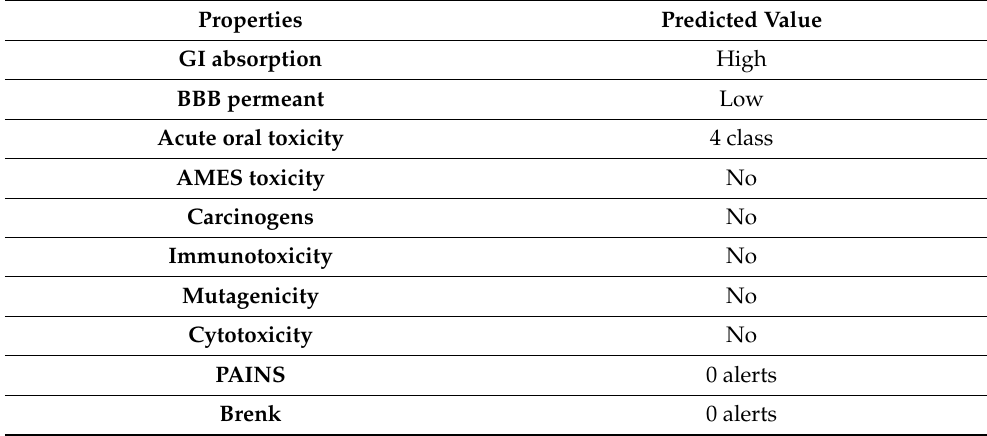
Table 5. Results of consensus prediction of ADMET properties of compound 2b .